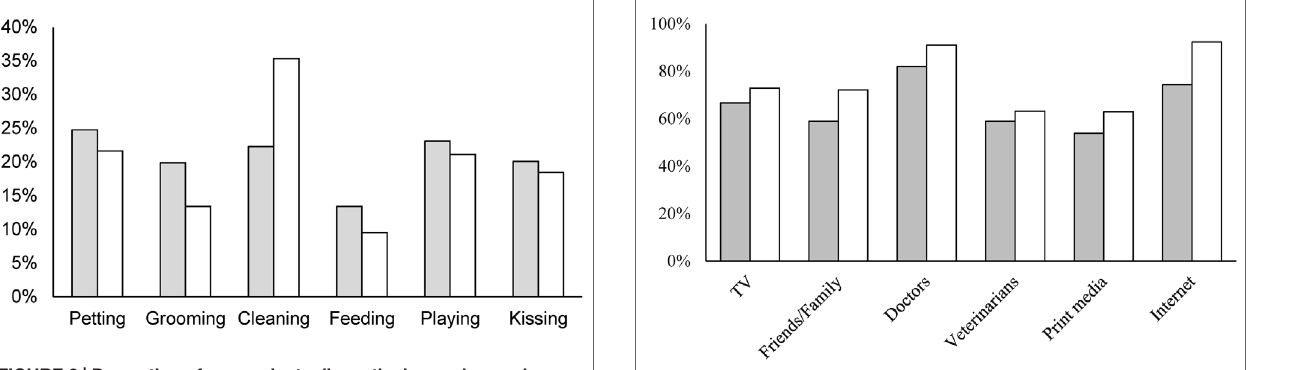
FigUre 3 | sources for which participants would seek information on animal contact and associated health outcomes. Gray bars are for pet owners and white bars are for non-pet